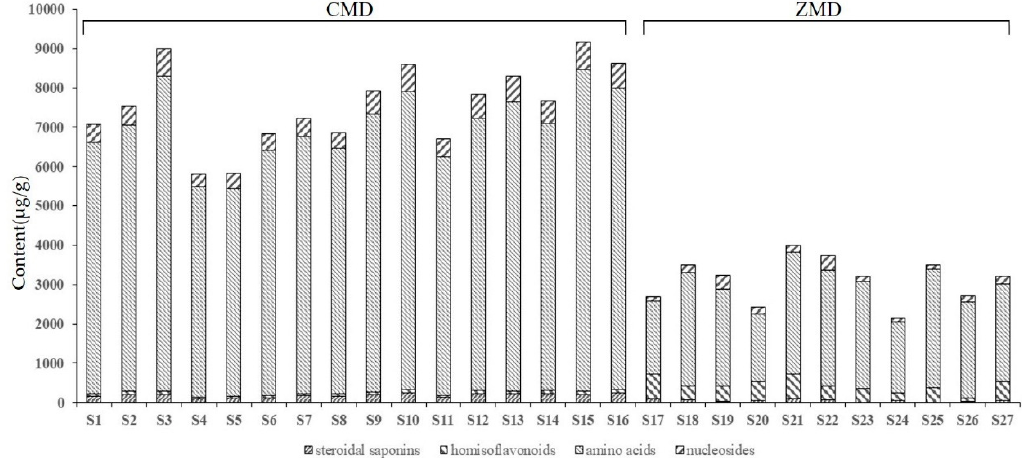
Figure 2. The contents of four kinds of chemical components in Ophiopogonis Radix from different producing areas.